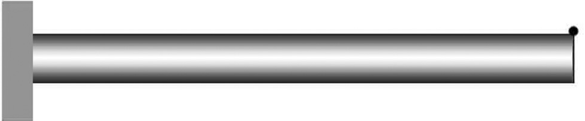
Figure 1: The geometric diagram of cantilevered SW - BNNT with an extra mass attached on the surface at the free